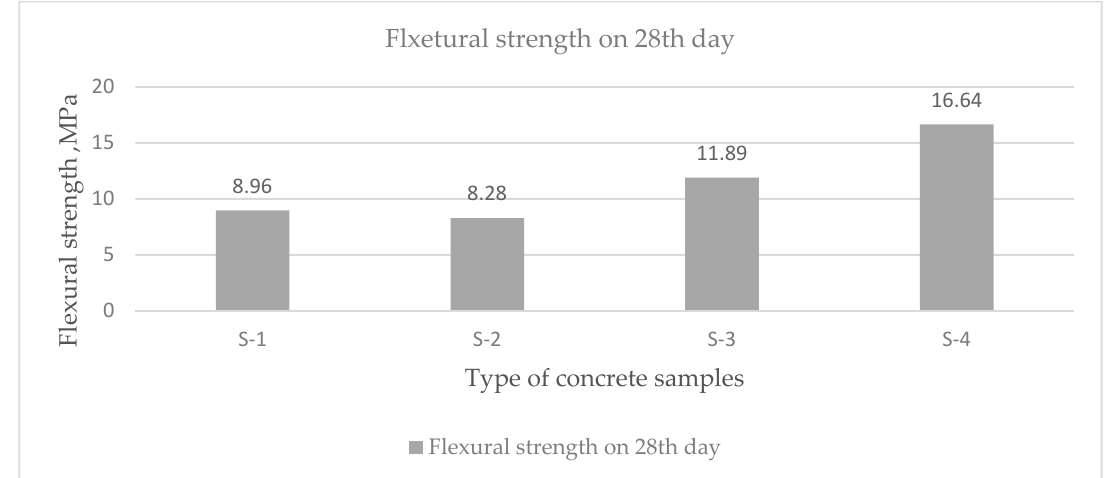
Figure 5. Flexural strength of concrete samples on the 28th day.